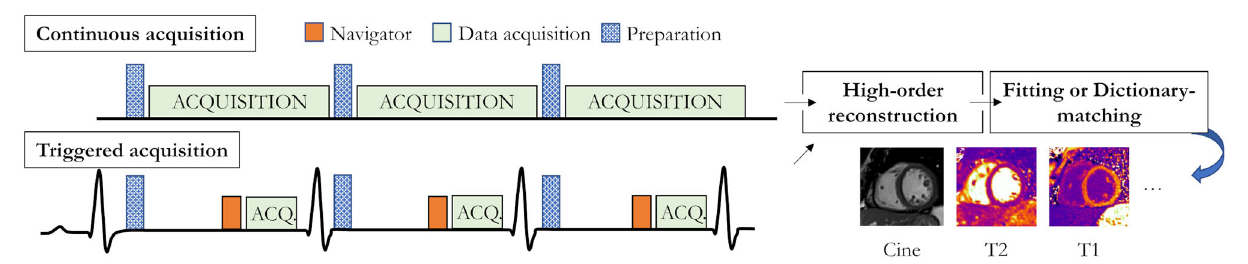
FIGURE 6 | Recent acquisition strategies for single scan multiparametric cardiac mapping. Both accurate and precise continuous acquisition (top) and triggered acquisition (bottom) strategies have been proposed. Preparation modules could for example be an inversion pulse (as shown in the triggered diagram) or a T 2 preparation